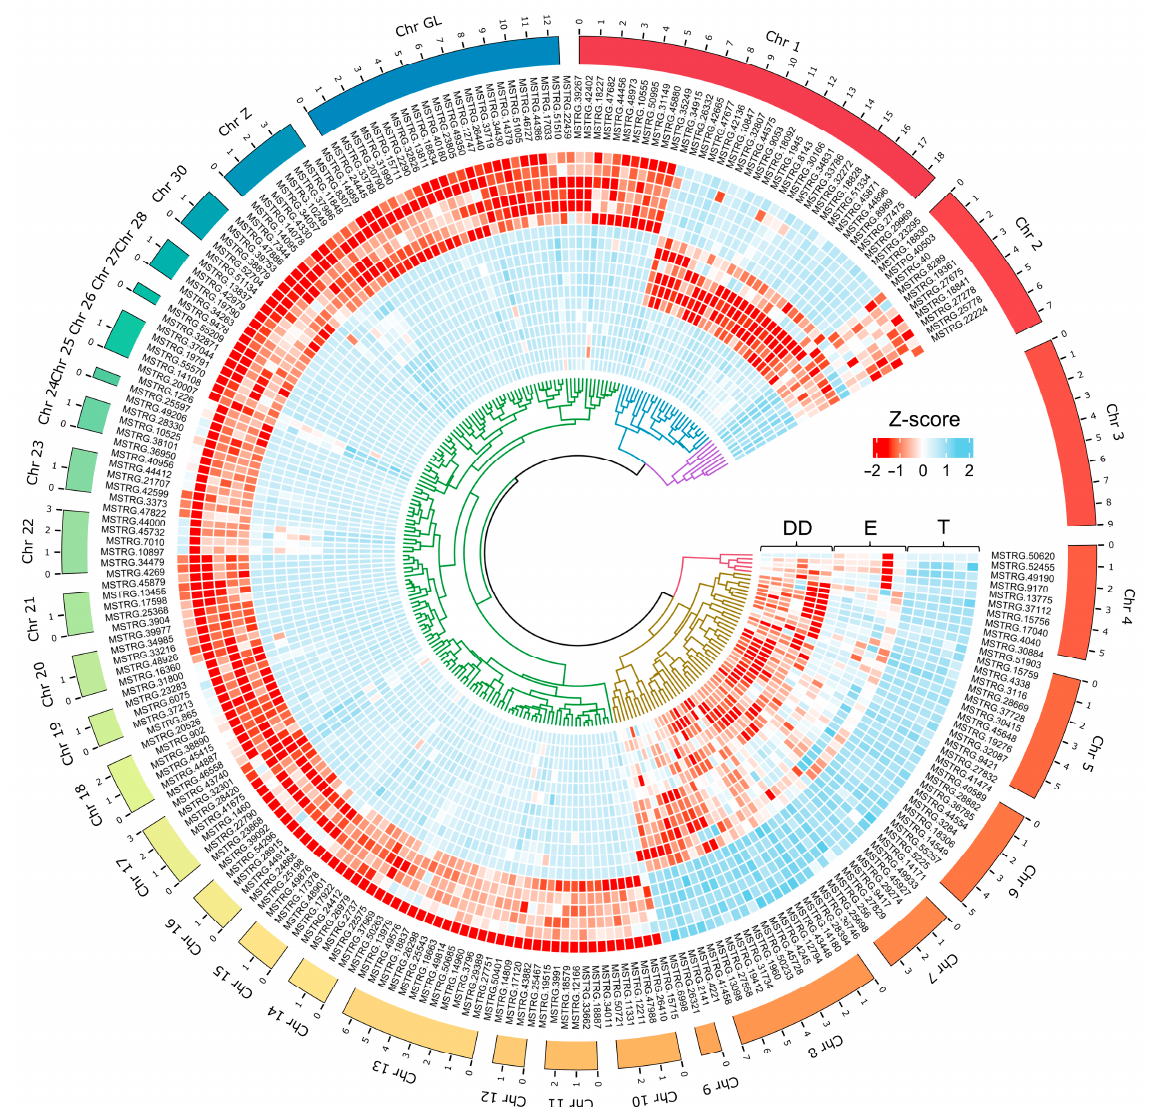
Figure 5. The expression heatmap (the Z-score of the FPKM value) of the identified lncRNAs in each sample of each tissue grouped in the clusters (the dendrogram inside). The outer bars’ length corresponds to the chromosomal distribution of the DELs.